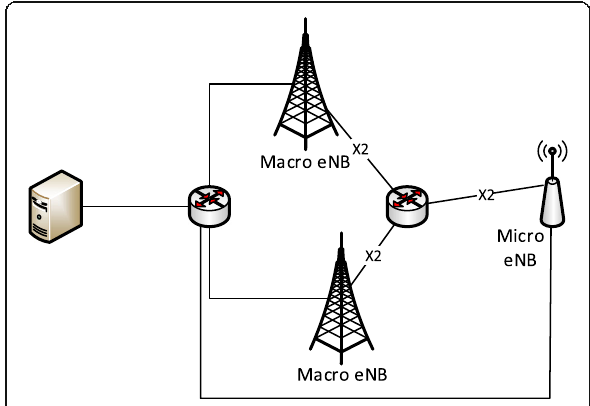
Fig. 13 Simulation scenario for Content-centric coordinated resource allocation strategies